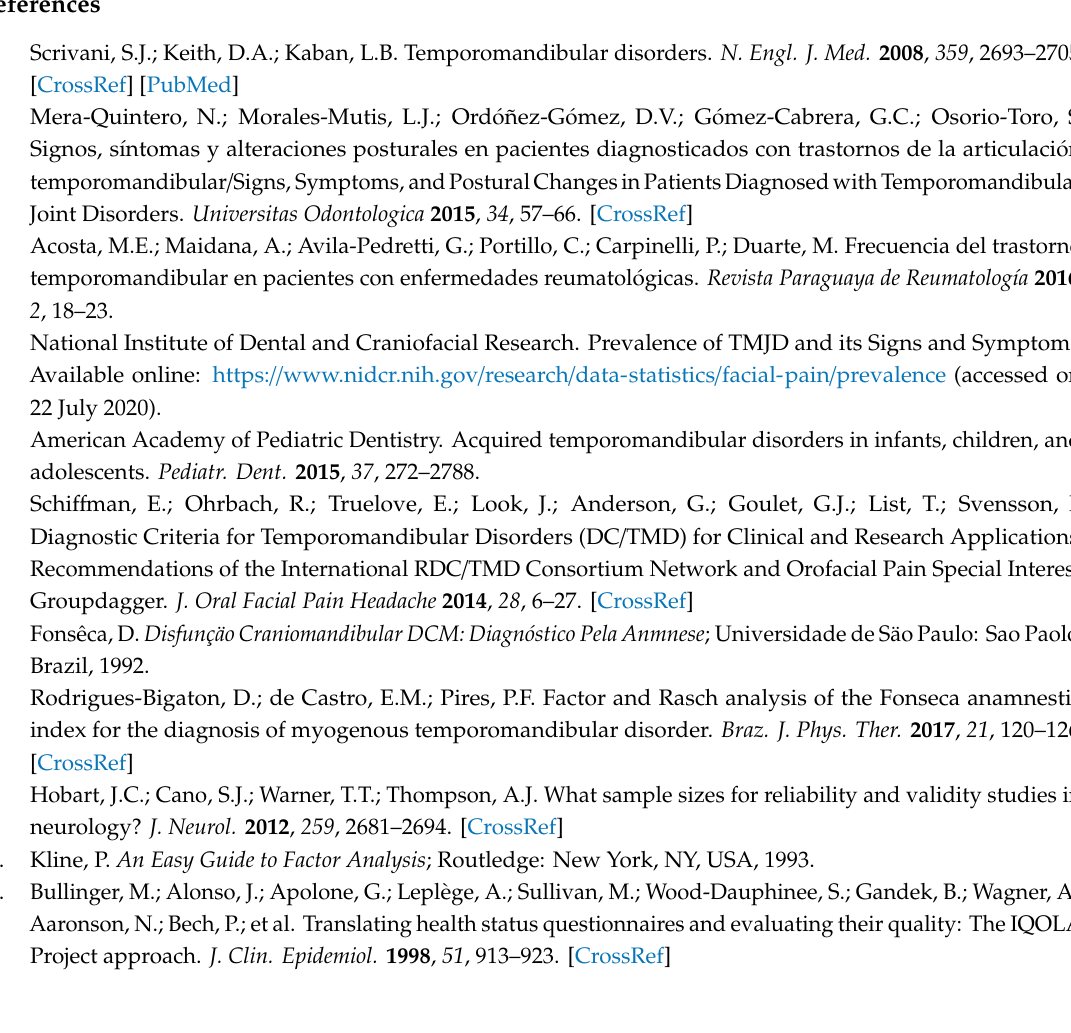
Table S1: Í ndice Anamn é sico de Fonseca. Versi ó n